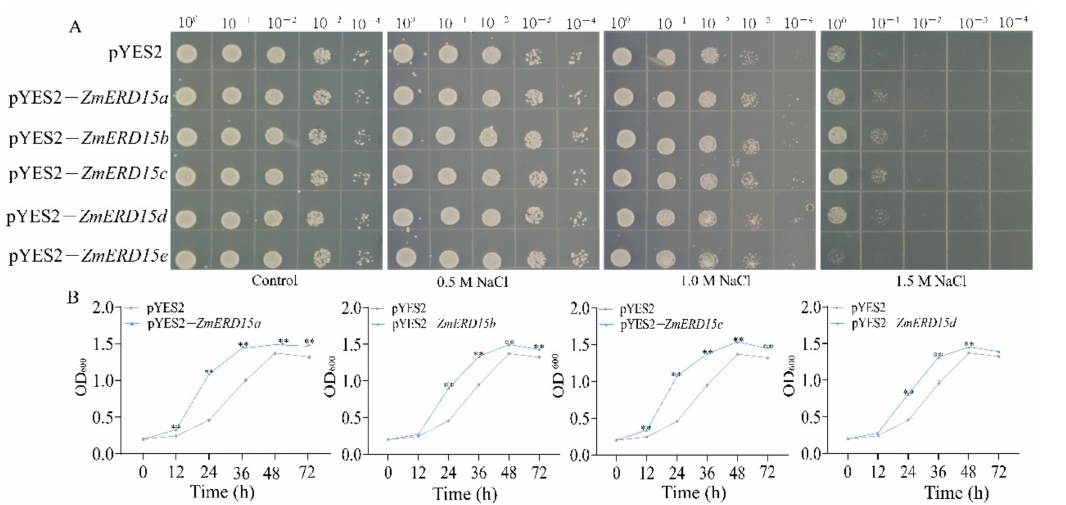
Figure 8. Phenotype of yeast strain expressing ZmERD15 under salt stress. ( A ) Phenotype of yeast strains on YNBUra − with 2% galactose plates supplemented with 0.5, 1.0, and 1.5 M NaCl, respectively. Photographs were taken after 3 days of incubation at 28 ◦ C in an incubator. ( B ) The growth curve of yeast cells in YNBUra − with 2% galactose liquid medium supplemented with 1.5 M NaCl for 3 days at 28 ◦ C. ** indicates a significant difference at p <